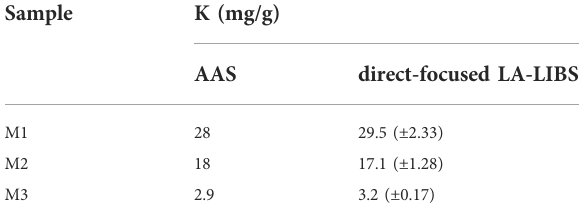
TABLE 6 Comparison of analysis results.